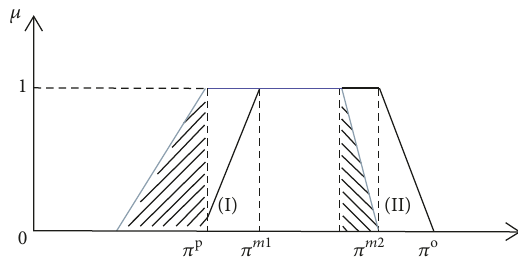
Figure 3: Principle of three-objective optimization approach.